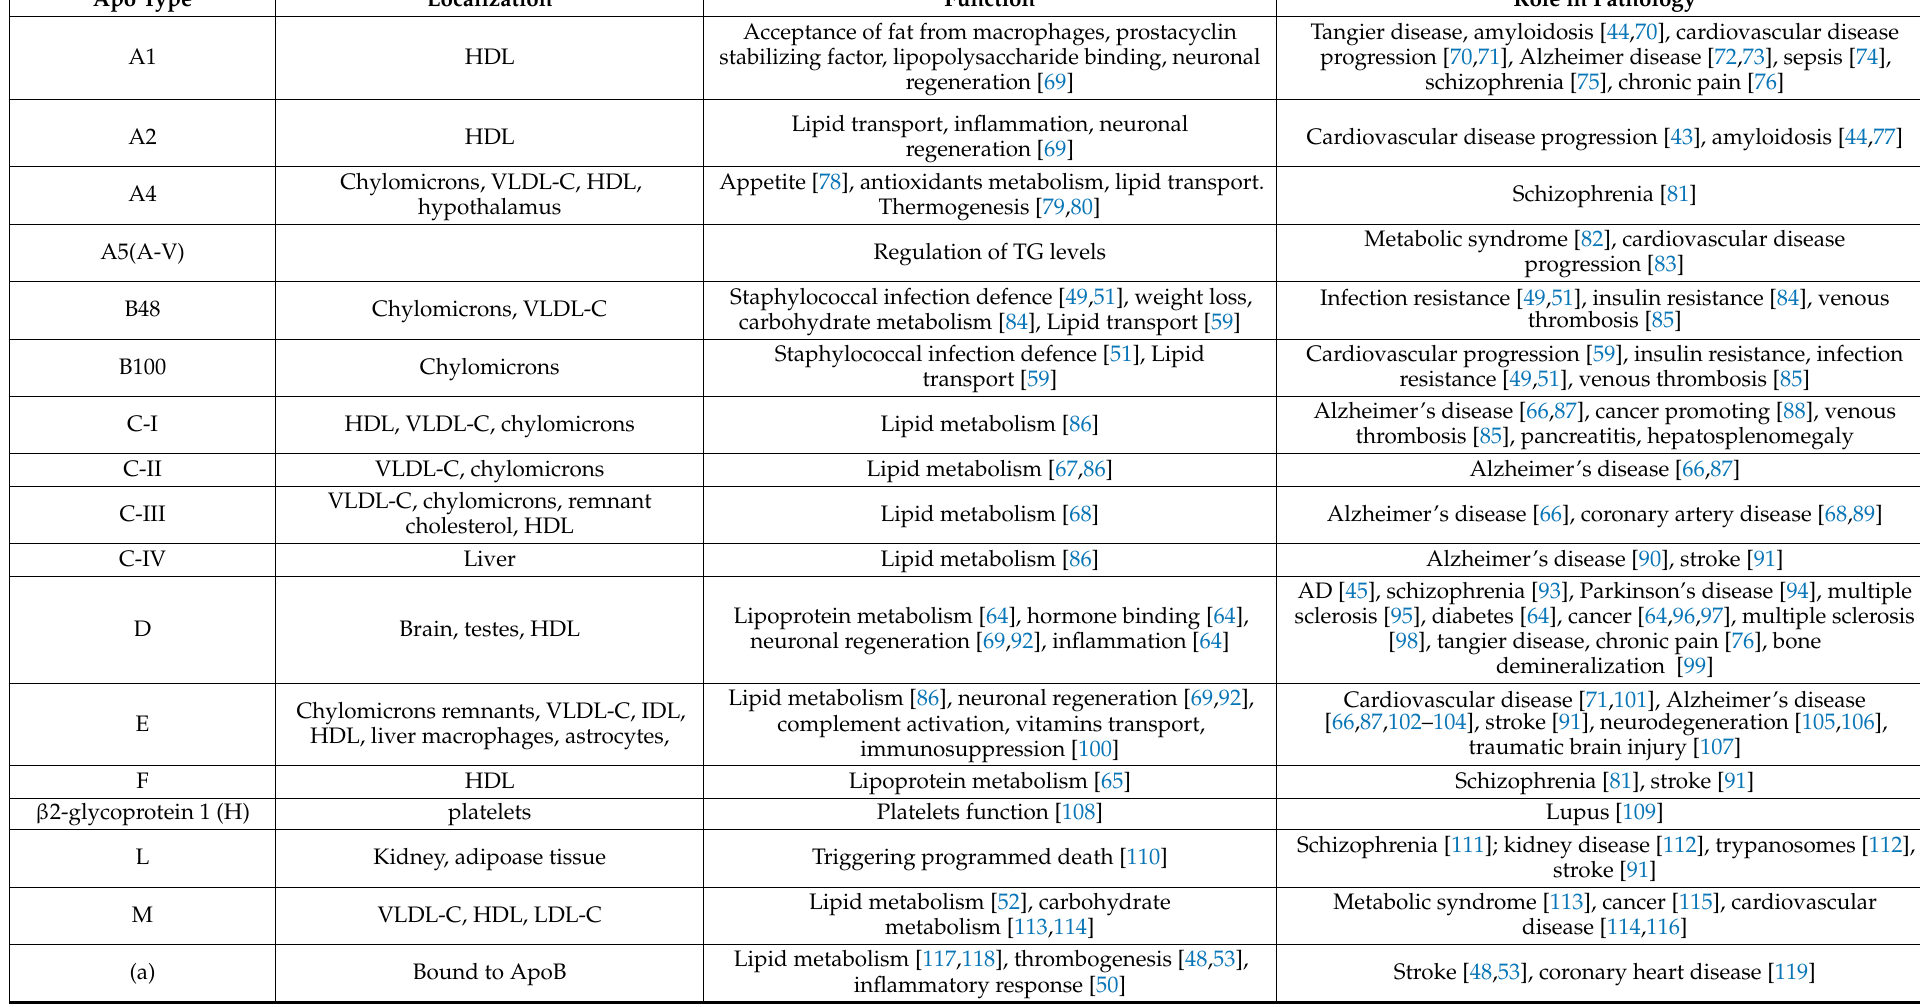
Table 1. Linkage of abnormalities in lipoproteins to emergence of pathological